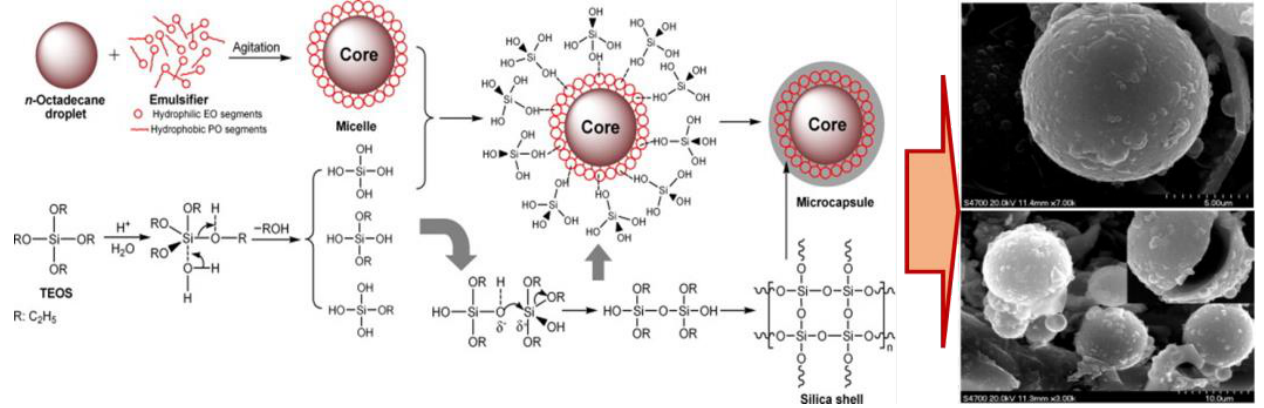
Figure 6. A sol-gel technique is used to produce C18/SiO 2 microcapsules [42]. A summary of some example encapsulated of PCCs is represented in Table 2. Table 2. Summary for encapsulated PCCs.